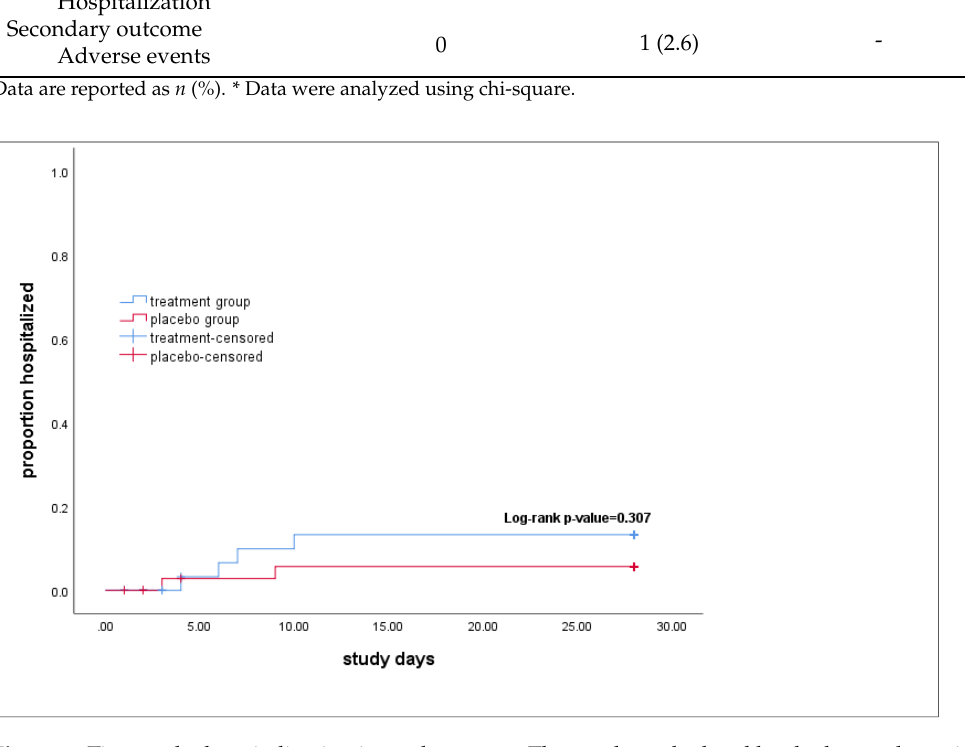
Figure 2. Time to the hospitalization in study groups. The p -value calculated by the log-rank test in Kaplan–Meier analysis showed no difference in the time to hospitalization between the treatment and the placebo groups.